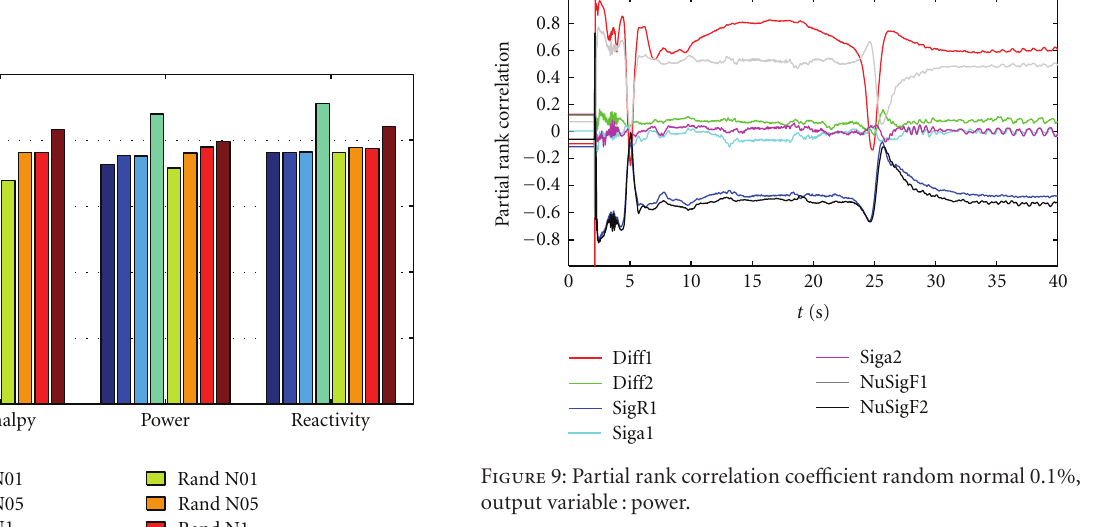
Figure 6: Partial rank correlation coe ffi cient for maximum power, maximum enthalpy, and maximum reactivity for random normal 0.1% case (1: Di ff 1 , 2: Di ff 2 , 3: SigR1 , 4: Siga1 , 5: Siga2 , 6: NuSigF1 , 7: NuSigF2 ).